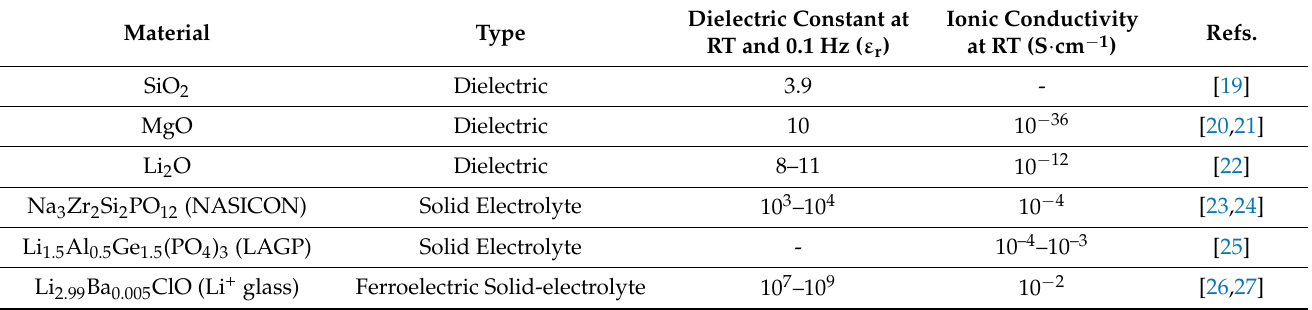
Table 1. Physical properties of the studied dielectrics and solid